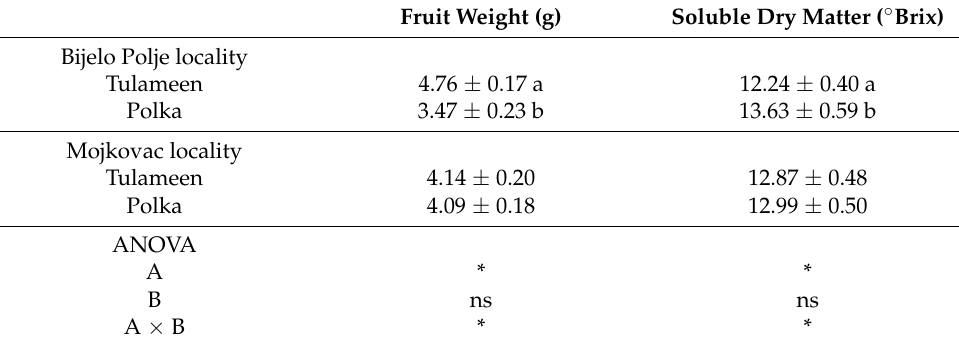
Table 2. Raspberry fruit weight (g) and soluble dry matter content.